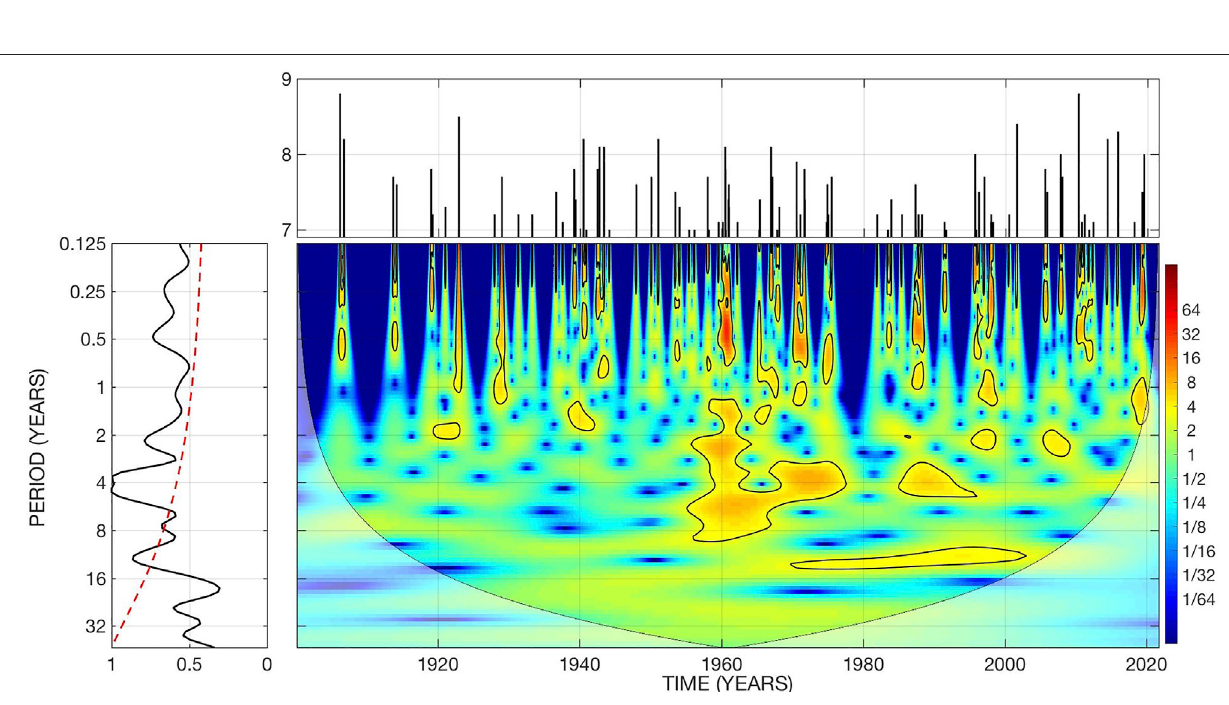
Frontiers in Earth Science |